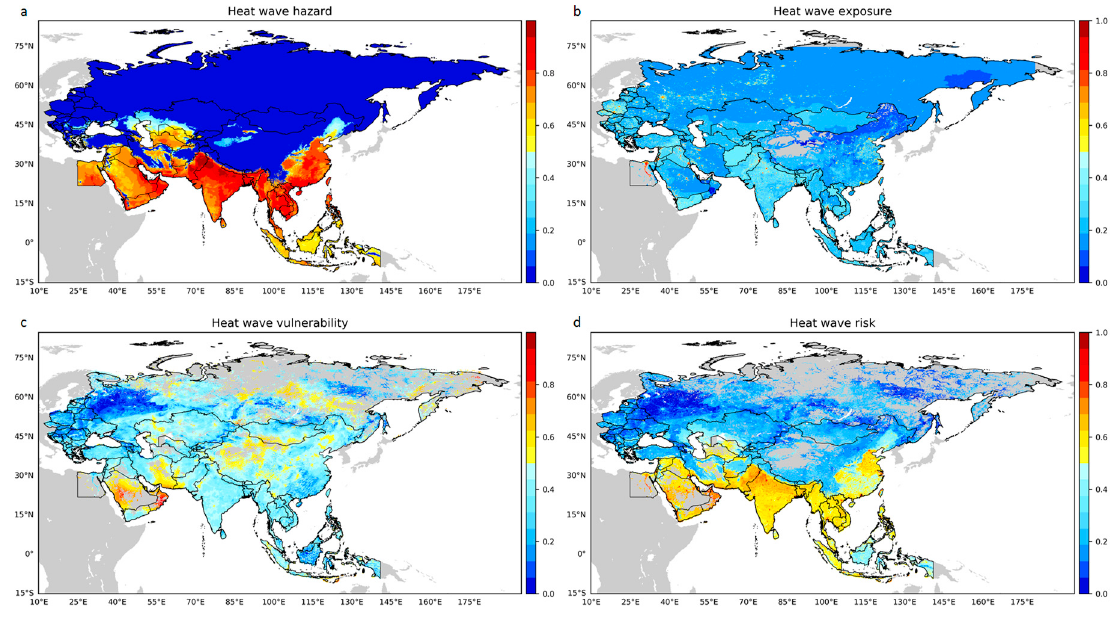
Figure 9. Heat wave risk assessment: ( a ) Heat wave hazard; ( b ) Heat wave exposure; ( c ) Heat wave vulnerability; ( d ) Heat wave risk.